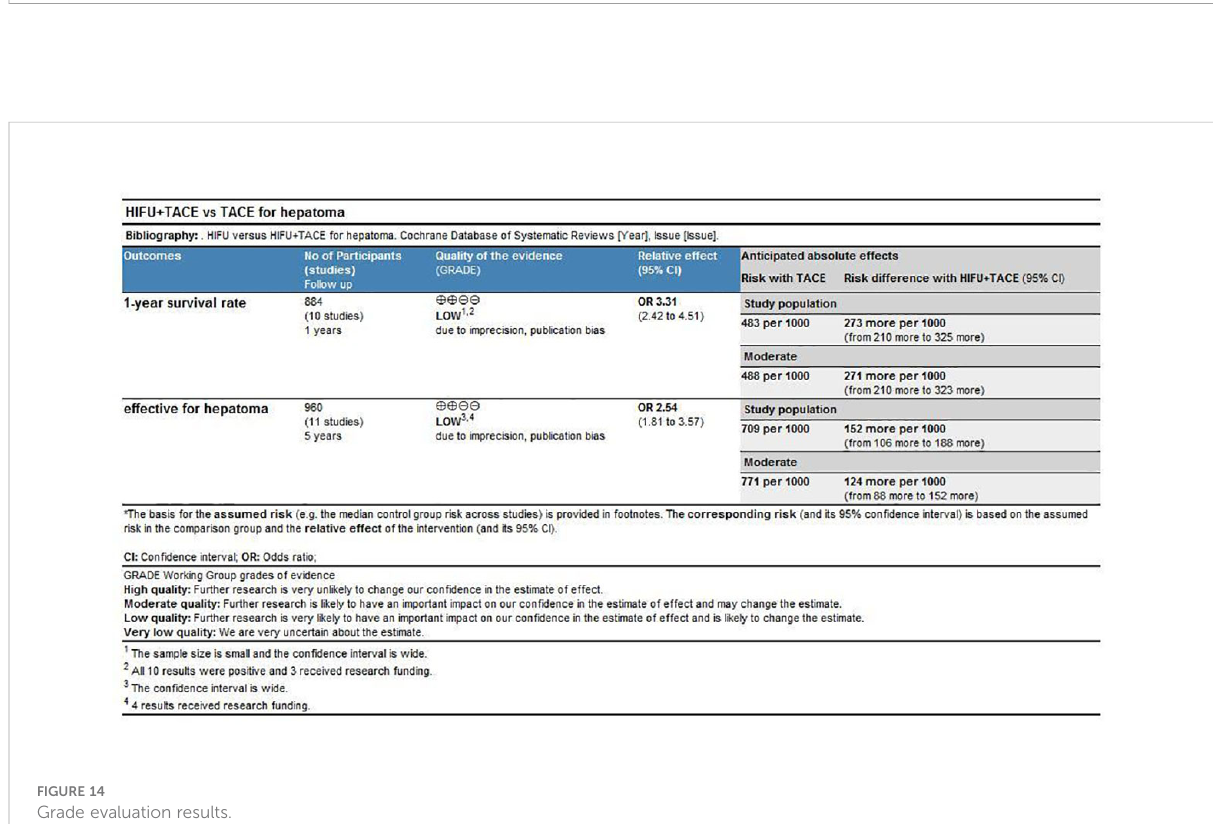
FIGURE 14 Grade evaluation